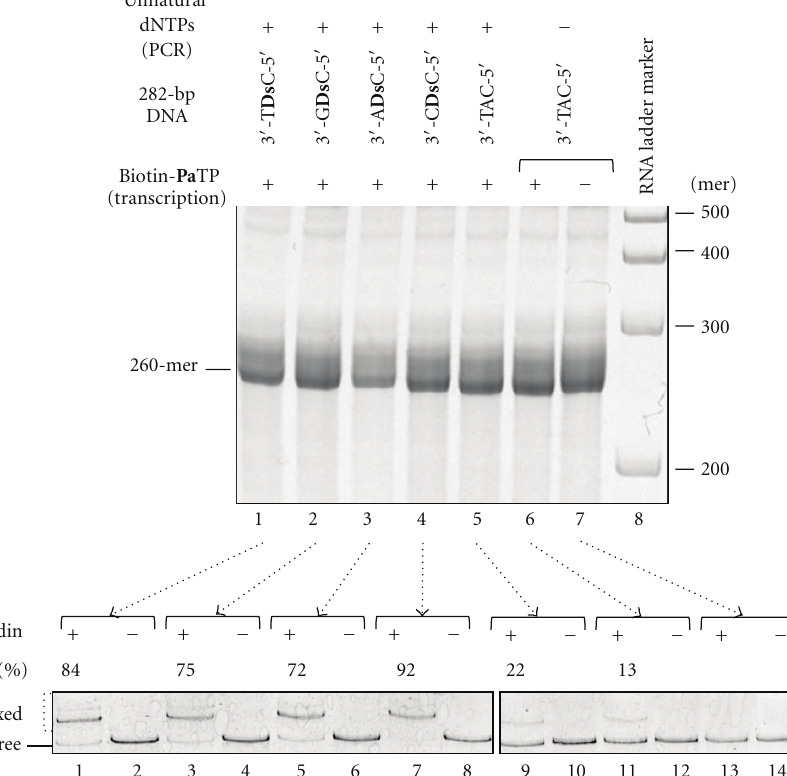
Figure 4: T7 transcription for site-specific biotin labeling of 260-mer transcripts. Transcripts from each 282-bp DNA template containing 3 (cid:3) -T Ds C-5 (cid:3) , 3 (cid:3) -G Ds C-5 (cid:3) , 3 (cid:3) -A Ds C-5 (cid:3) , or 3 (cid:3) -C Ds C-5 (cid:3) , in the presence of the natural NTPs (2mM) and Biotin- Pa TP (2mM), were analyzed on a 5% denaturing polyacrylamide gel (upper gel image). After the purification of each 260-mer transcript, gel-mobility shift assays were performed using streptavidin. Biotinylated RNA-streptavidin complexes were separated from free RNAs on an 8% nondenaturing polyacrylamide gel, and the amounts of the complexes (yields) were determined from the band intensities. The experiments were independently repeated twice, and representative data are shown. The gel-mobility shift values were averaged from two data sets.